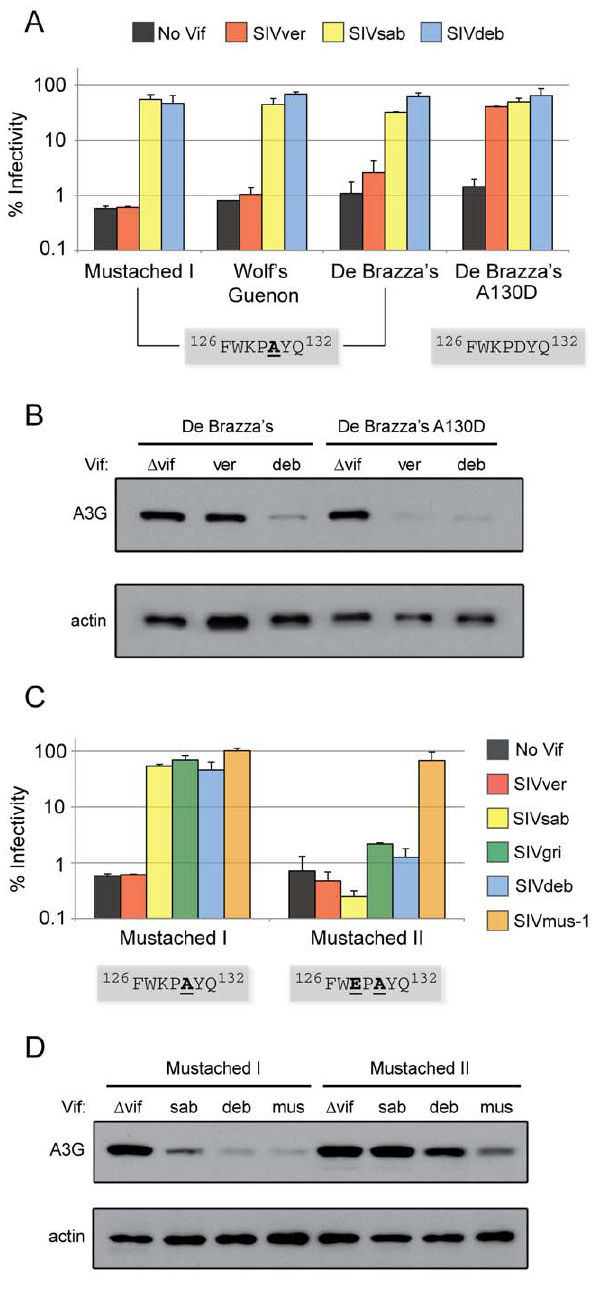
Figure 2. Adaptive evolution of A3G at codons 128 and 130 allows escape from Vif-mediated antagonism. Single-round infectivity assays were performed with HIV-1 D Vif and HIV-1 expressing SIV Vif proteins produced in the presence of A3G variants from monkeys of the Cercopithecus genus in (A) and (C). Infectivity of viruses is reported as a percentage, relative to infectivity in the absence of A3G (100%). Error bars indicate standard deviation from the mean of two independent transfection experiments (six infection replicates in total). The Vif binding site of each A3G variant is depicted in grey boxes. (A) and (C) The primate A3G gene used is listed under the graph, while the source of the Vif genes were either no Vif (black box), SIVagm.ver (orange), SIVagm.sab (yellow), SIVdeb (blue), SIVagm.gri (green), or SIVmus-1 (golden). Anti-HA western blot analysis was used to measure A3G expression in virus producer cells in (B) and (D). Anti-ß-actin served as protein loading controls.